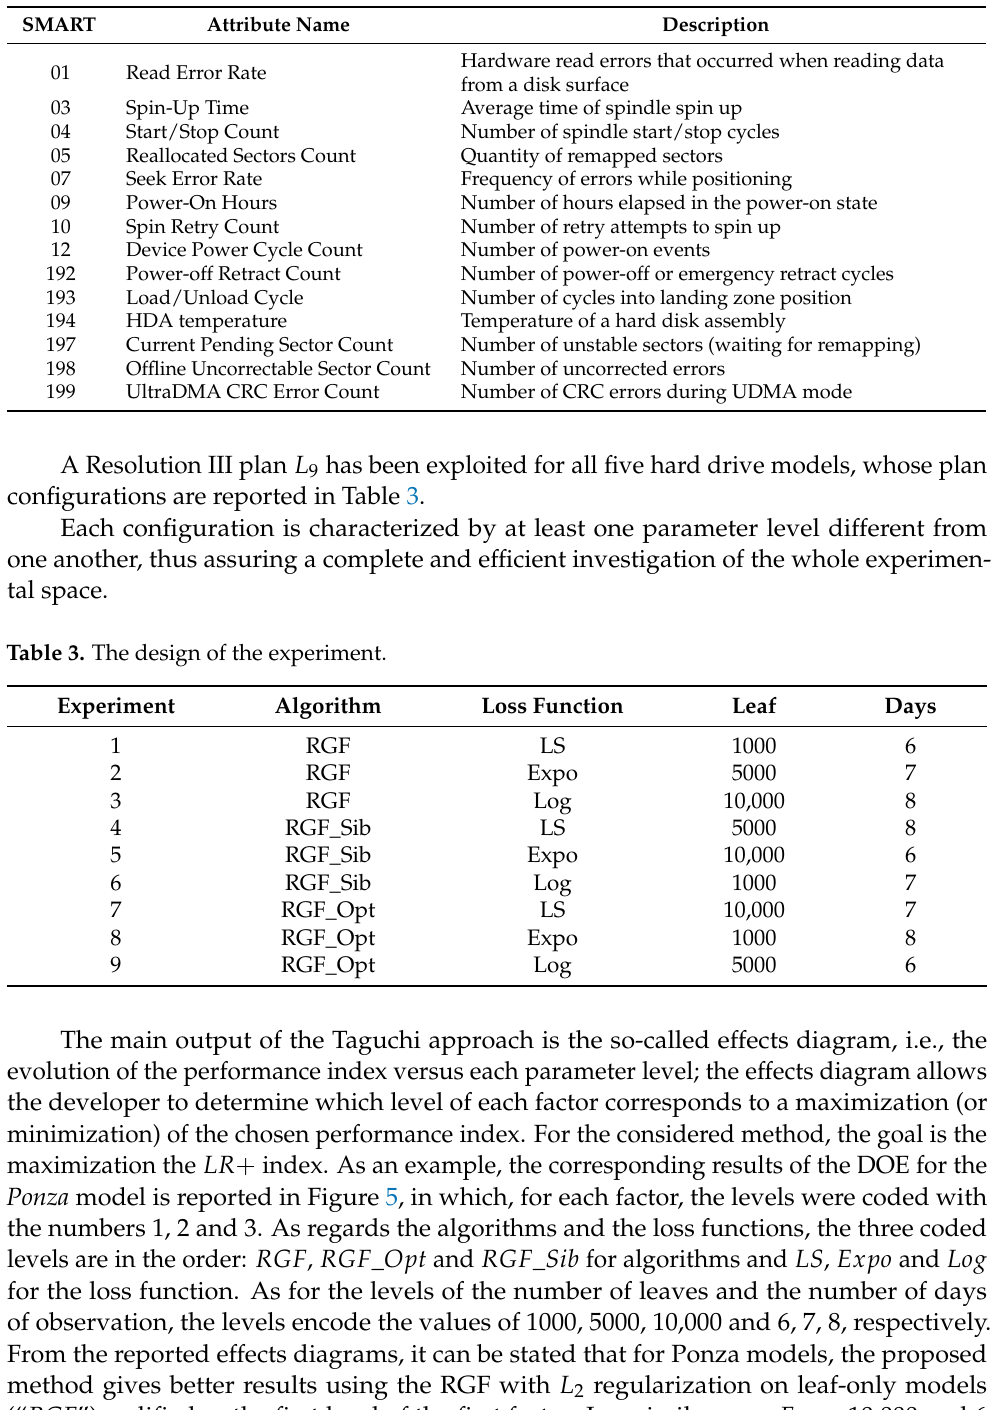
Table 2. Selected SMART Attributes [18].